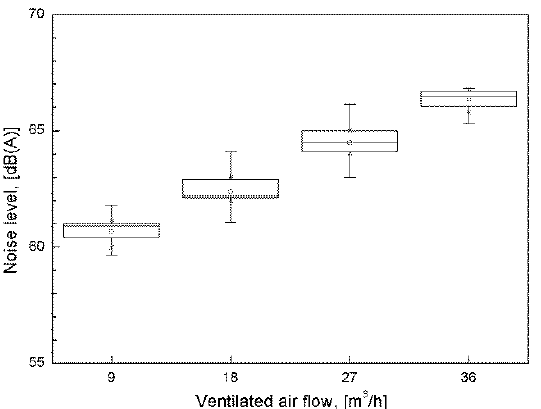
Figure 17. Noise levels in the test room (with background ventilation and ALTAIR in operation – 10 s time step).